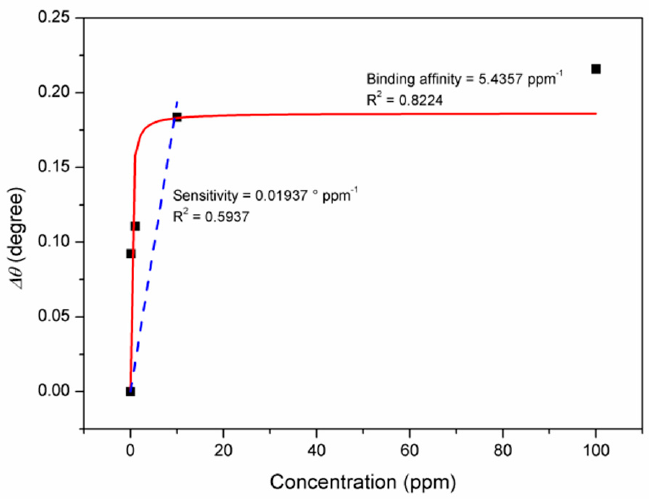
Figure 9. Data plotting the angle shift against the cobalt ion concentration fitted with Langmuir equation and linear fitting.